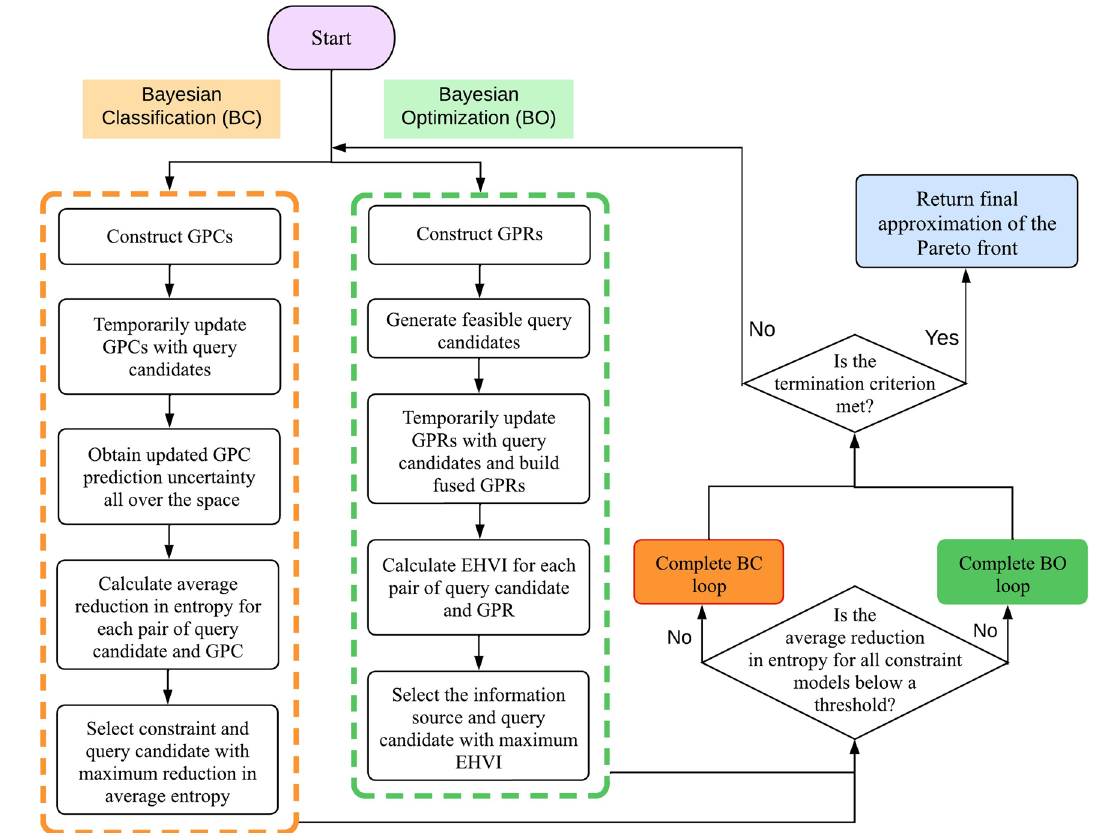
Fig. 1 Schematic of the Bayesian optimization framework with active learning of the design constraints. In every iteration of the framework, both Bayesian classi fi cation and Bayesian optimization loops run in parallel. The algorithm starts with Bayesian classi fi cation and switches to Bayesian optimization once the average reduction in entropy of all constraint models falls below a threshold. The framework switches back to Bayesian classi fi cation if a valuable experiment is suggested